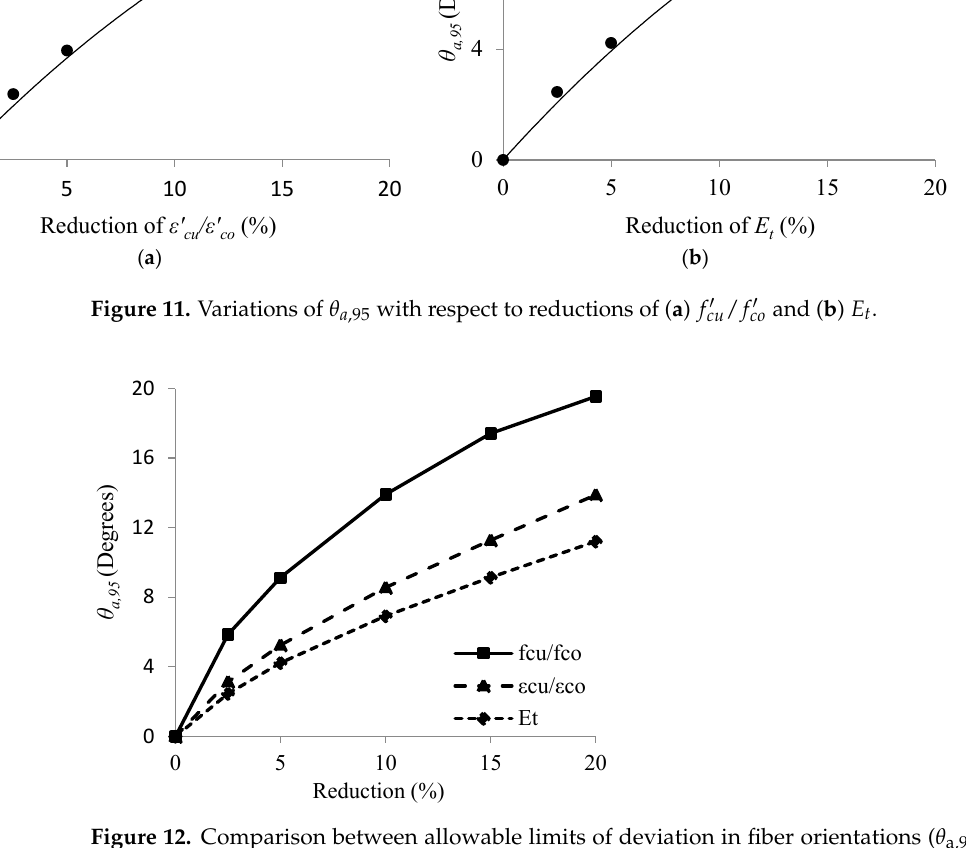
Figure 12. Comparison between allowable limits of deviation in fiber orientations ( θ a,95 ) for each compressive